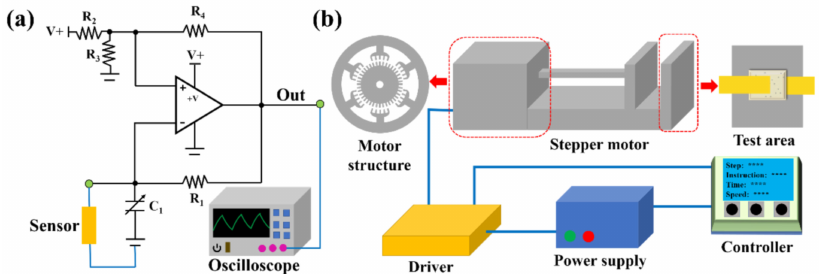
Figure 10. Schematic of the ( a ) capacitance detection circuit and ( b ) pressure application systems.